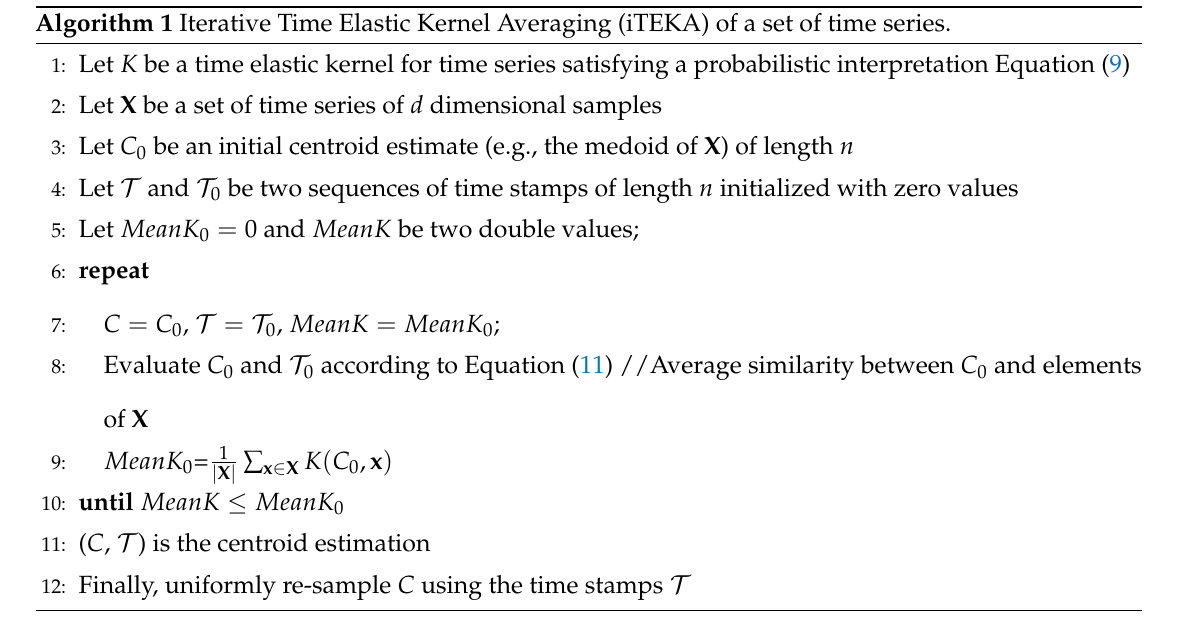
Algorithm 1 Iterative Time Elastic Kernel Averaging (iTEKA) of a set of time